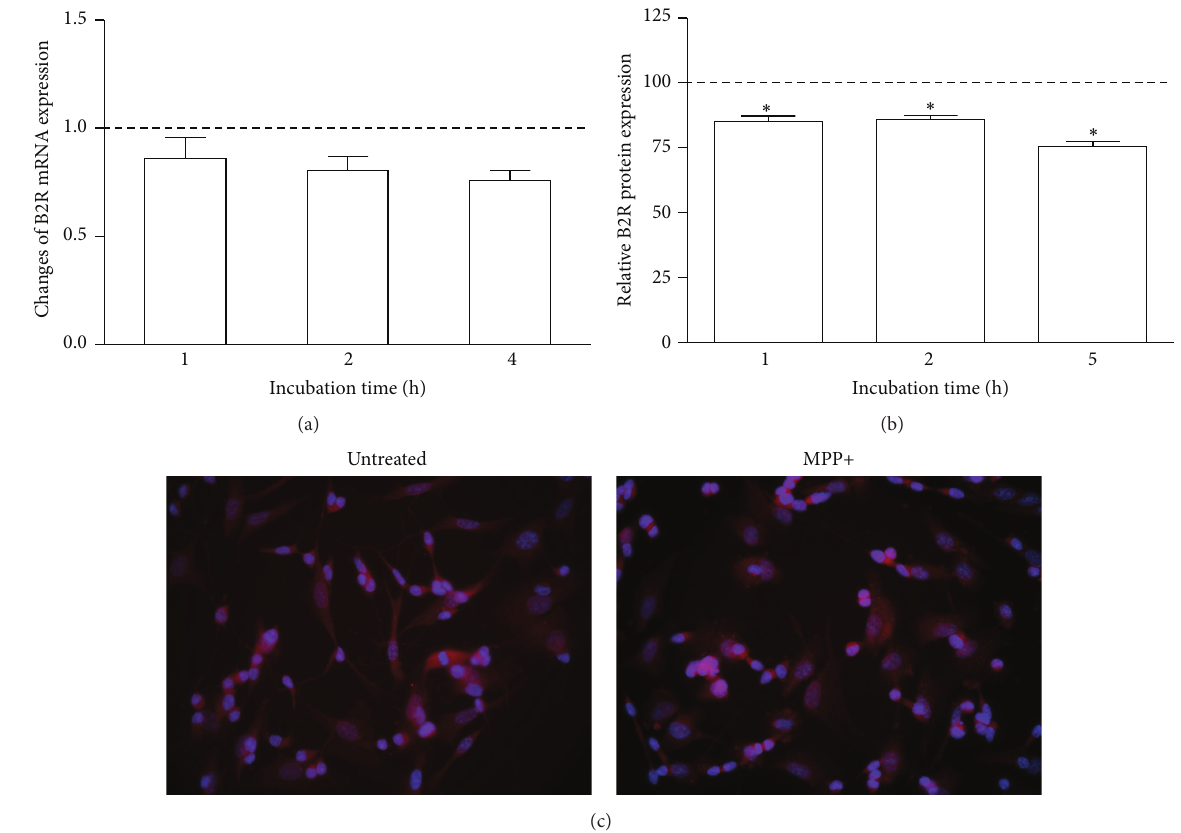
Figure 7: The effect of MPP+ on B2R expression in differentiated SK-N-SH cells. Confluent cells were incubated with MPP+ at different time intervals. (a) Real-Time PCR analysis of the B2R mRNA expression after different incubation time. mRNA expression is shown as relative mean values as compared to untreated cells, assumed to possess value equal to 1 (dashed line). The expression of B2R protein was analyzed by immunocytochemistry with specific antibodies and the quantification of fluorescence signal was performed as described in Materials and Methods(b).Theresultsareshownasmean ± SDofthechangesincomparisontountreatedcells,assumedtopossess100%expression(dashed line). (c) The photographs show B2R expression by differentiated SK-N-SH cells without or after 5-hour incubation with MPP+. ∗ 𝑃 < 0.05 versus untreated